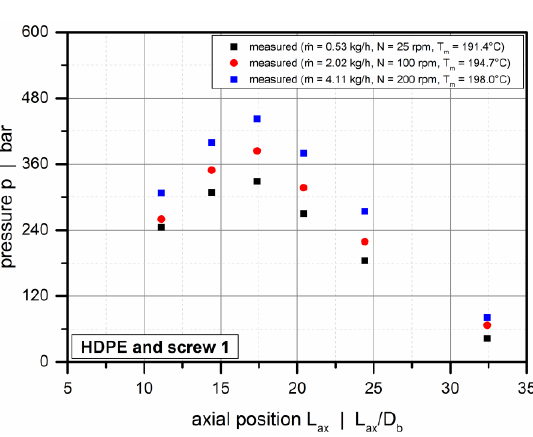
Figure 13d Polymers 2018 , 10 , x FOR PEER REVIEW